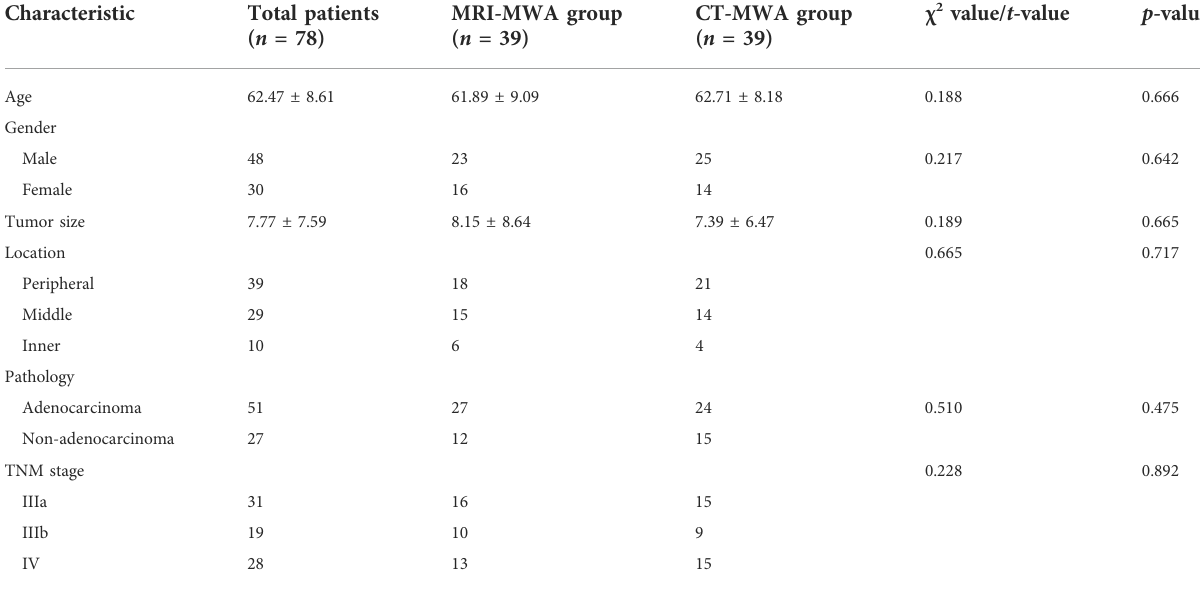
TABLE 2 Clinical characteristics of patients undergoing MRI-guided microwave ablation (MRI-MWA group) or CT-guided microwave ablation (CT- MWA group) to treat pulmonary malignancies. χ 2 value/ t -value p -value Characteristic Total patients MRI-MWA group CT-MWA group ( n = 78) ( n = 39) ( n = 39) Age 62.47 ± 8.61 61.89 ± 9.09 62.71 ± 8.18 0.188 0.666